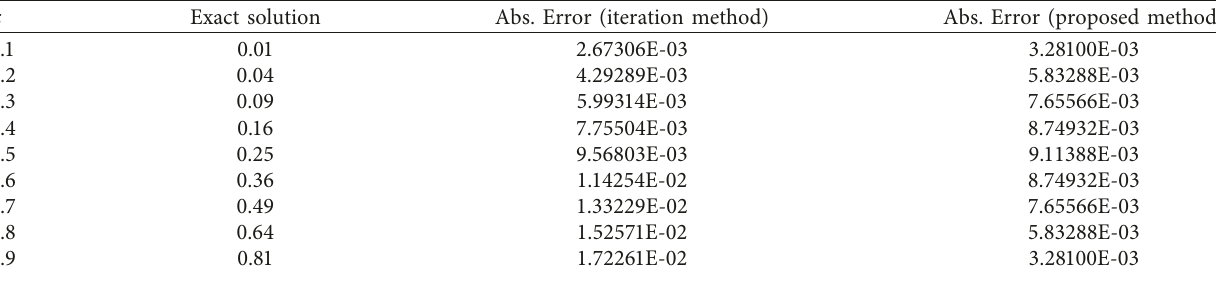
Table 1: Comparison of the absolute errors obtained by proposed method with the iteration method used in [17] for Example 1. x Exact solution